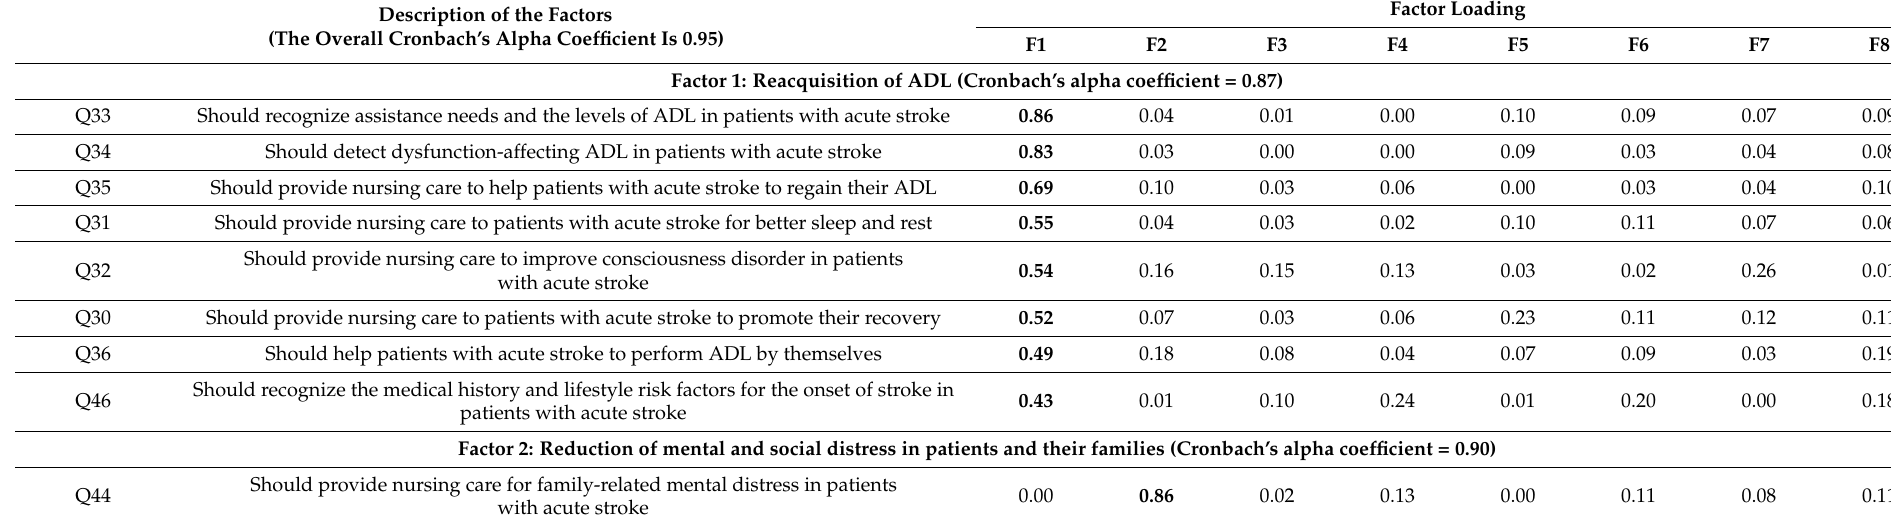
Table 2. Results of exploratory factor analysis on the awareness of the need for nursing for patients with acute CVA. Description of the Factors (The Overall Cronbach’s Alpha Coefficient Is